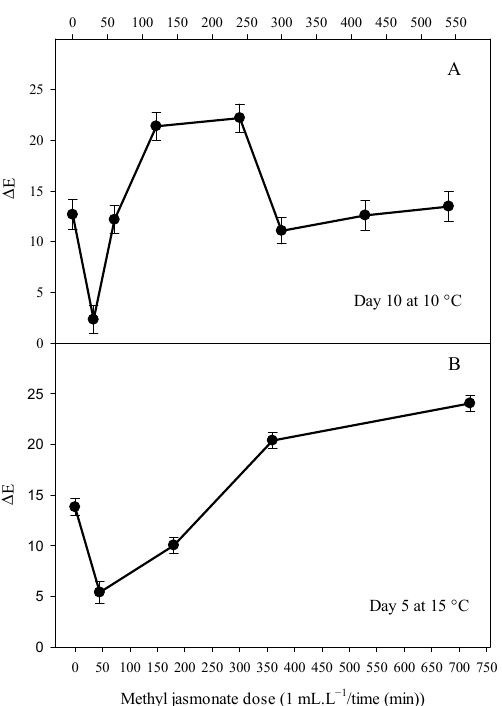
Figure 1. Hormetic dose determination for ethanol and methyl jasmonate. The determination of the hormetic dose of the stress chemicals ethanol ( A ) and methyl jasmonate ( B ) was based on the total color difference ( ∆ E) at the end of the storage period. Data points are means + standard deviation of the mean for n =